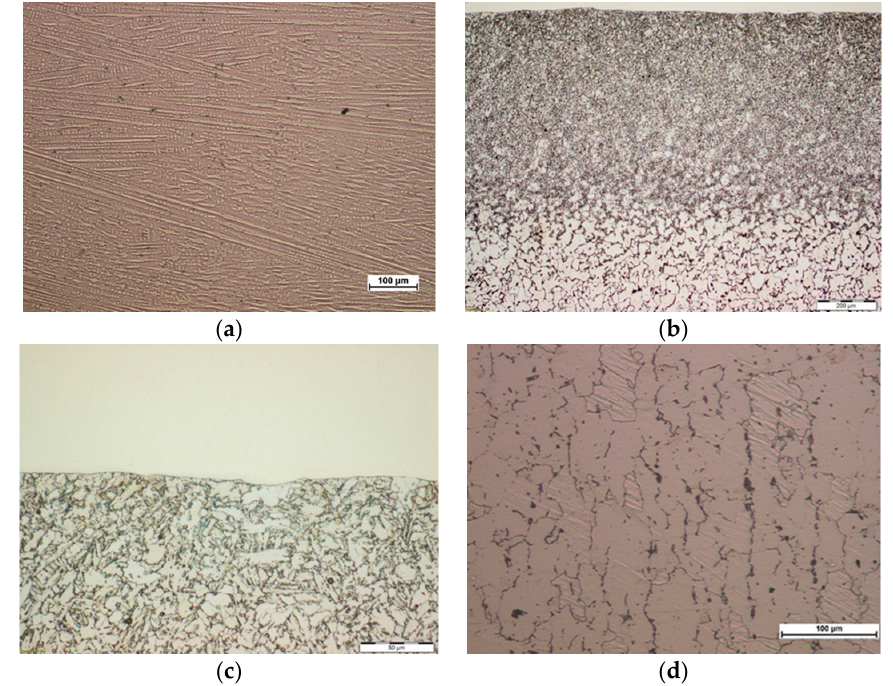
Figure 5. View of the microstructure of Inconel 625 superalloy coating layer obtained in the process of plasma powder transferred arc surfacing on the outer surface of 16Mo3 steel pipe (sample P2): ( a ) coating layer area, mag. 100×, ( b ) general view HAZ area mag. 100×, ( c ) HAZ area at the fusion line, mag. 500×, ( d ) base material, mag. 200×. Materials 2020 , 12 , x FOR PEER REVIEW